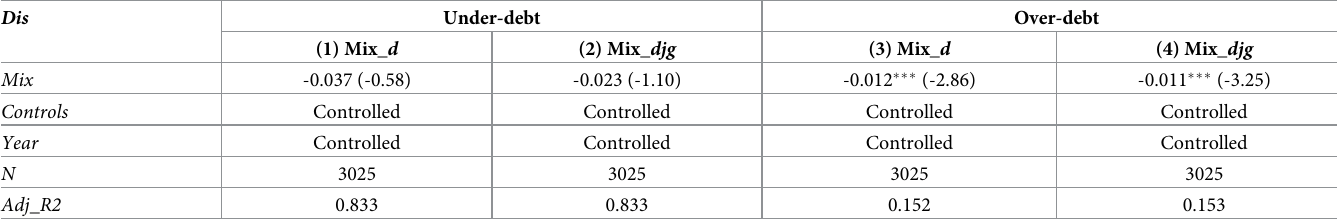
Table 6. The non-state-owned shareholder ‘s governance and the degree of deviation of capital structure.